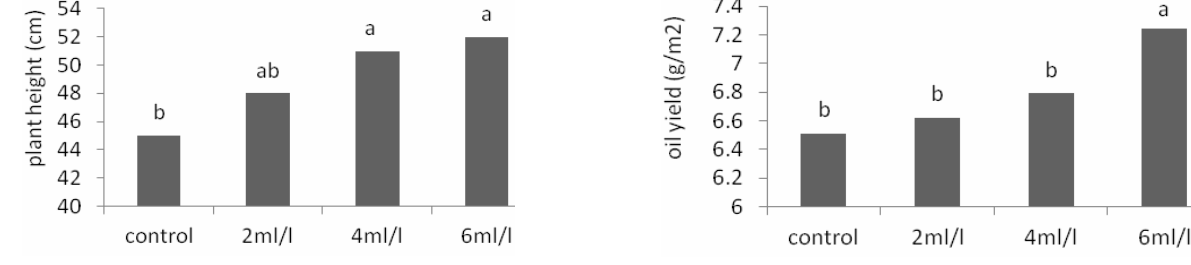
Fig.3. Effect foliar application on oil yield